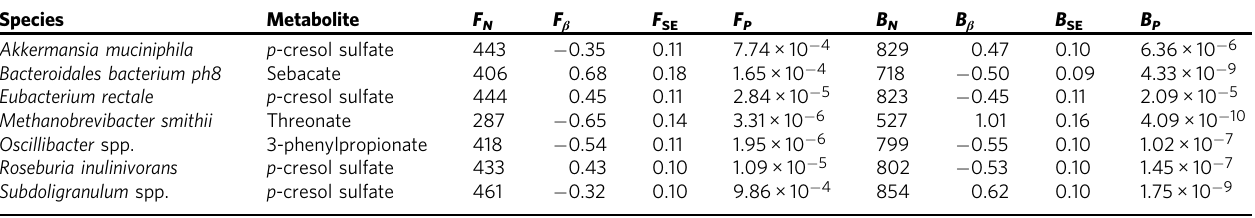
Table 1 Association between microbial species and the same named metabolite in both faeces and blood